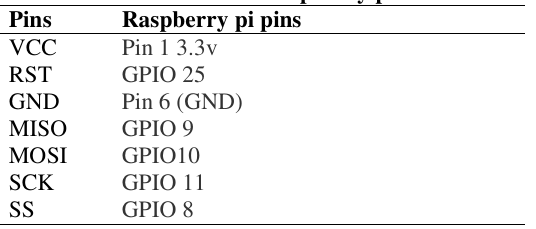
Fig. 5. Work diagram. The connection between the sensors and the raspberry pi will be shown in table (1) for the RFID sensor, and table (2) for DHT sensor. Connection of RFID with raspberry pi.